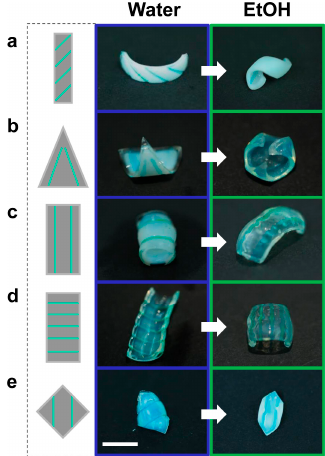
Figure 5. Unique shape responses of hydrogel bilayers enabled by external ionoprints. Left column : Schematic of the ionoprint design Middle column: Equilibrium shape in water at 40 °C. Right column : Equilibrium shape in EtOH at x 2 = 0.5. Scale bar = 5 mm. ( a – e ) In pure water above the LCST each actuator exhibits positive curvature and a dominant bending axis orthogonal to the ionoprint